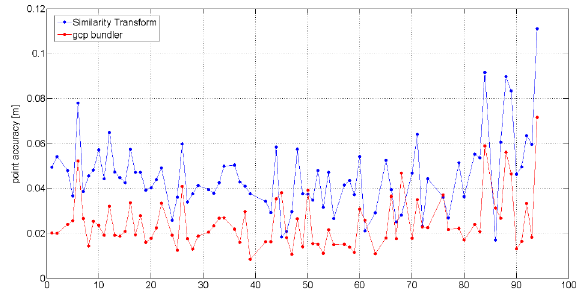
Figure 8: Using all 850 images and all available GCPs in the constrained bundle adjustment, a mean measurement uncertainty of 2.45cm is reached (Rumpler et al., 2014).